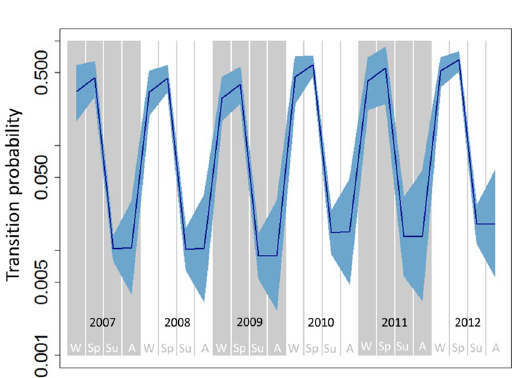
bars indicate point estimates and 95% confidence intervals, respectively.